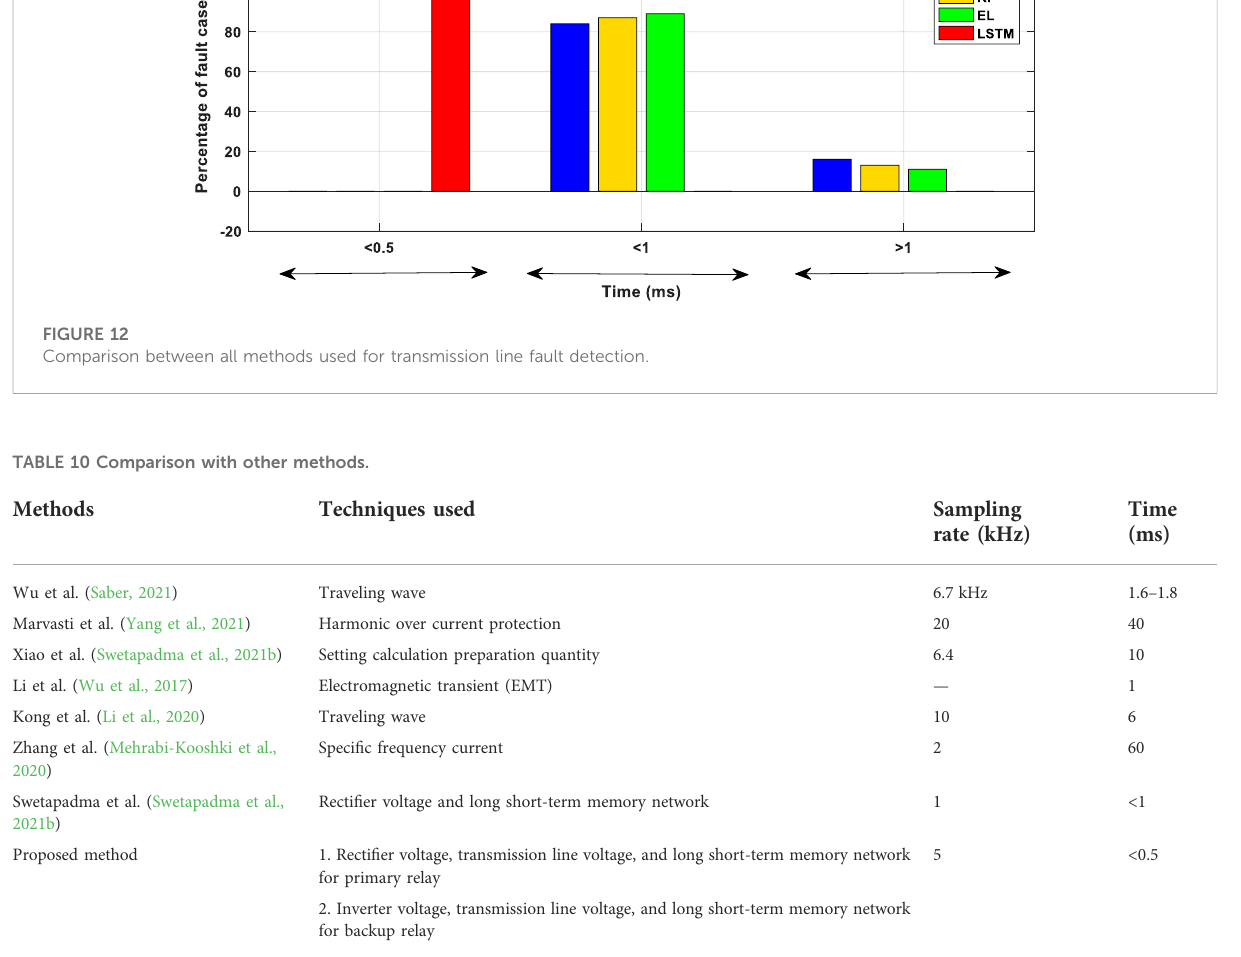
Table 5 shows the test results of the proposed method for varying fault resistance. Table 5 shows that the fault detection time is within 0.2 ms for all the tested fault cases using the